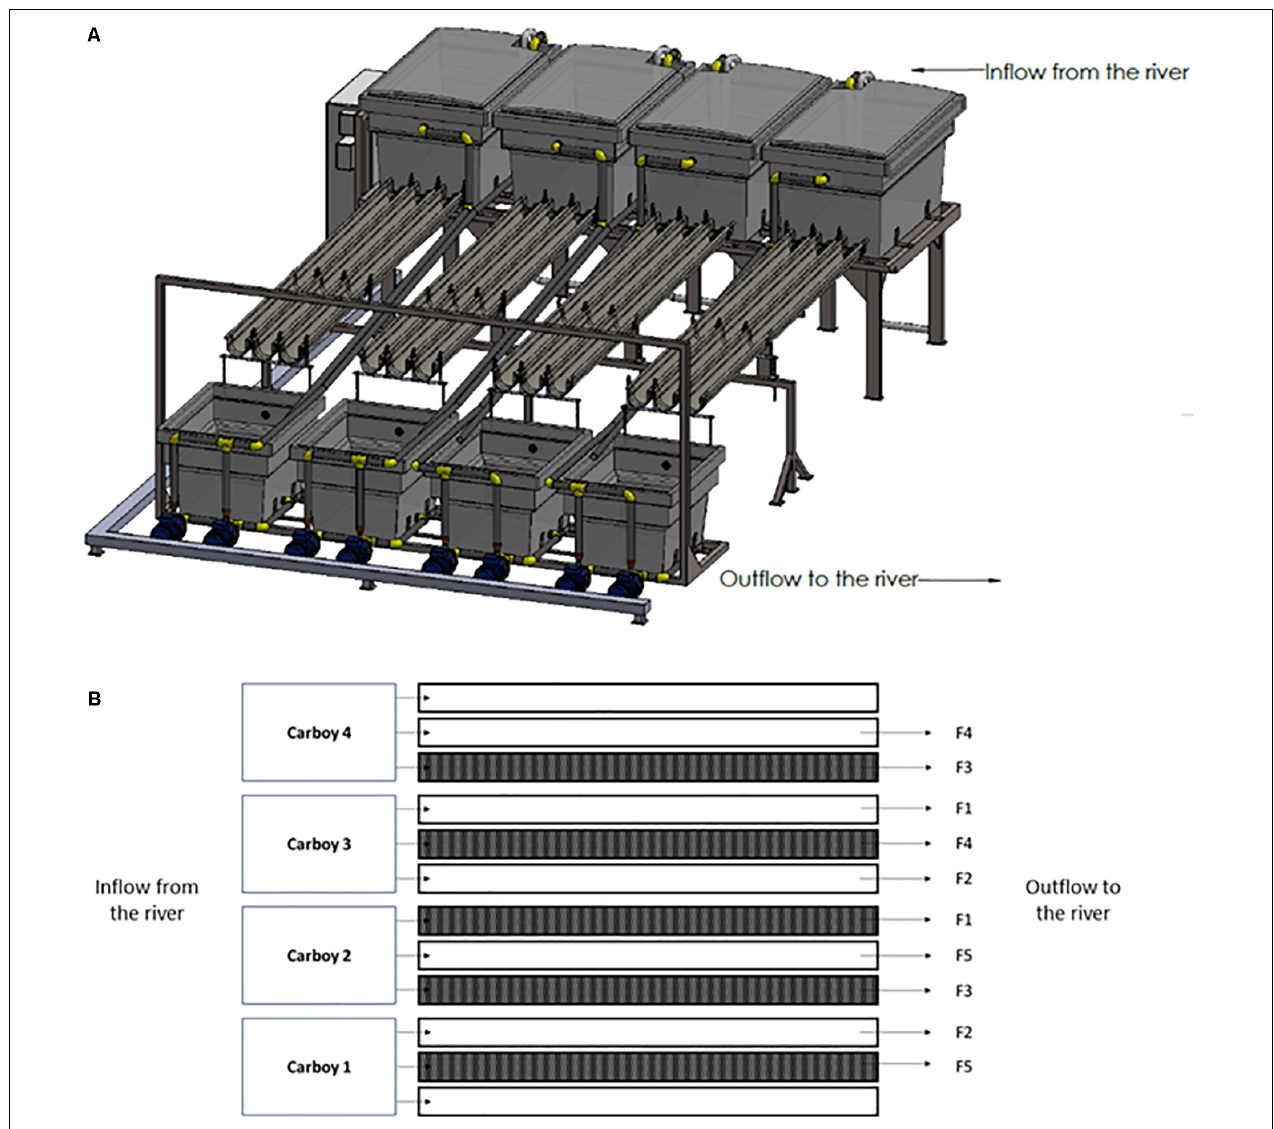
FIGURE 1 | Experimental rivers representation. (A) Three-dimensional representation, (B) scheme of the experimental design carried out where F1 = 0.09 L/s; F2 = 0.18 L/s; F3 = 0.36 L/s; F4 = 0.72 L/s; and F5 = 1.10 L/s. The dark represented flumes are those covered during the experiment for the Low Light